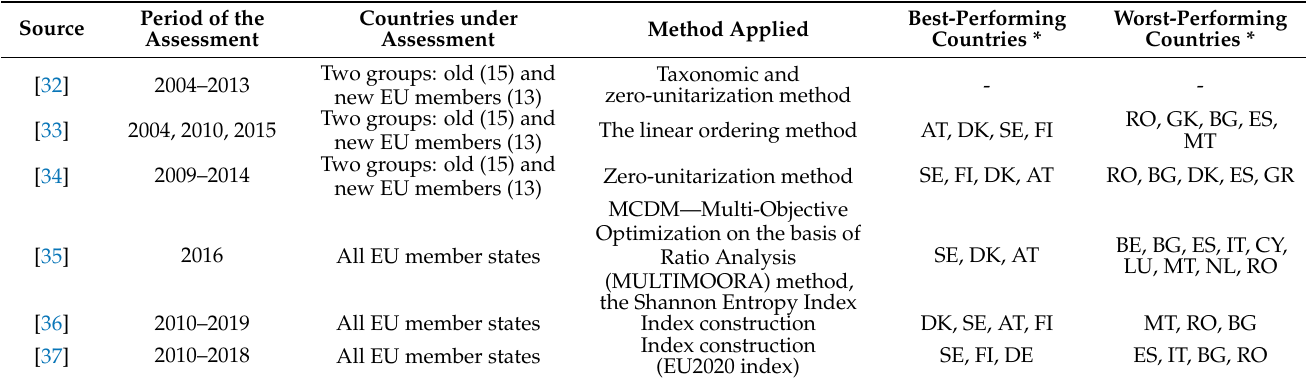
Table 2. The results summary of studies ranking the implementation of all Europe 2020 Strategy targets among